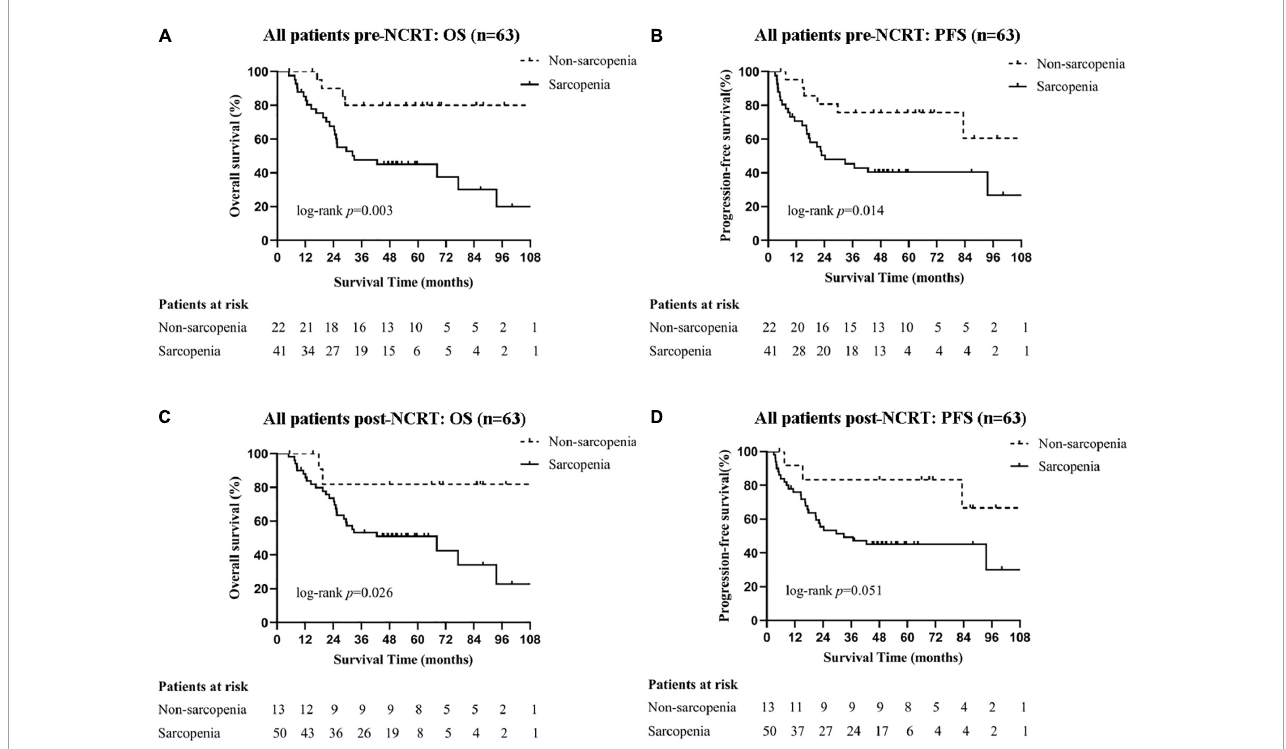
FIGURE2 Survival curves of all patients with different sarcopenic statuses. Pre-NCRT (A) OS and (B) PFS. Post-NCRT (C) OS, and (D) PFS. NCRT, neoadjuvant chemoradiotherapy; OS, overall survival; PFS, progression-free survival.